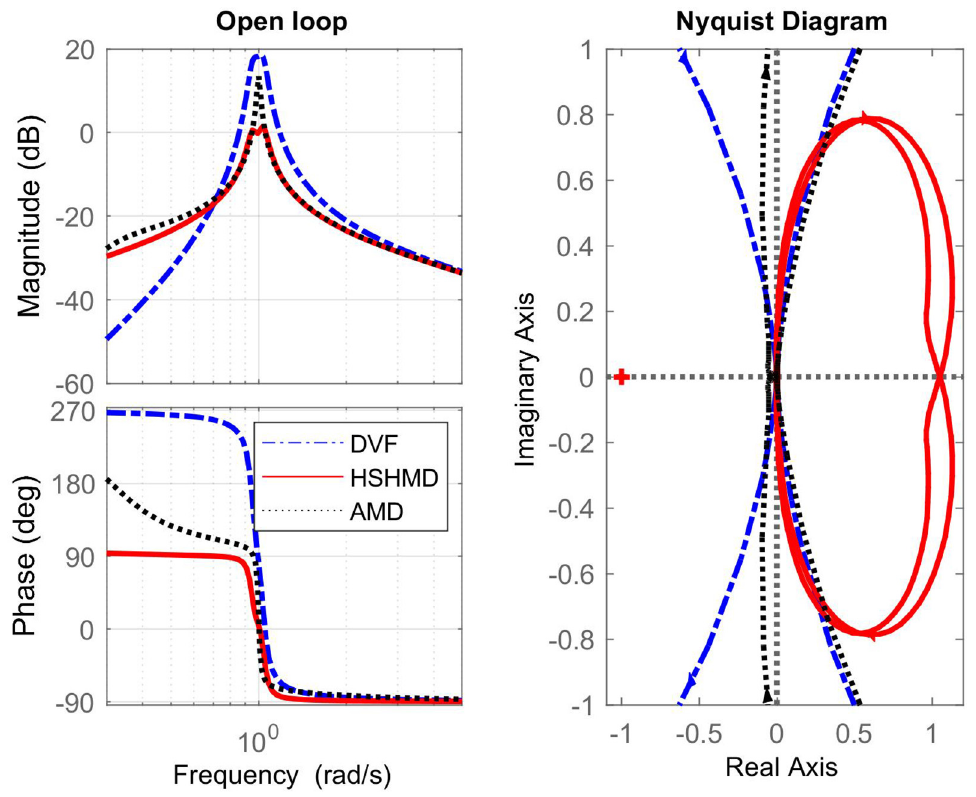
Fig. 4. Bode and Nyquist open loop transfer functions. Blue: Direct Velocity Feedback. Red: Hybrid SkyHook Mass Damper. Black: Active Mass Damper.